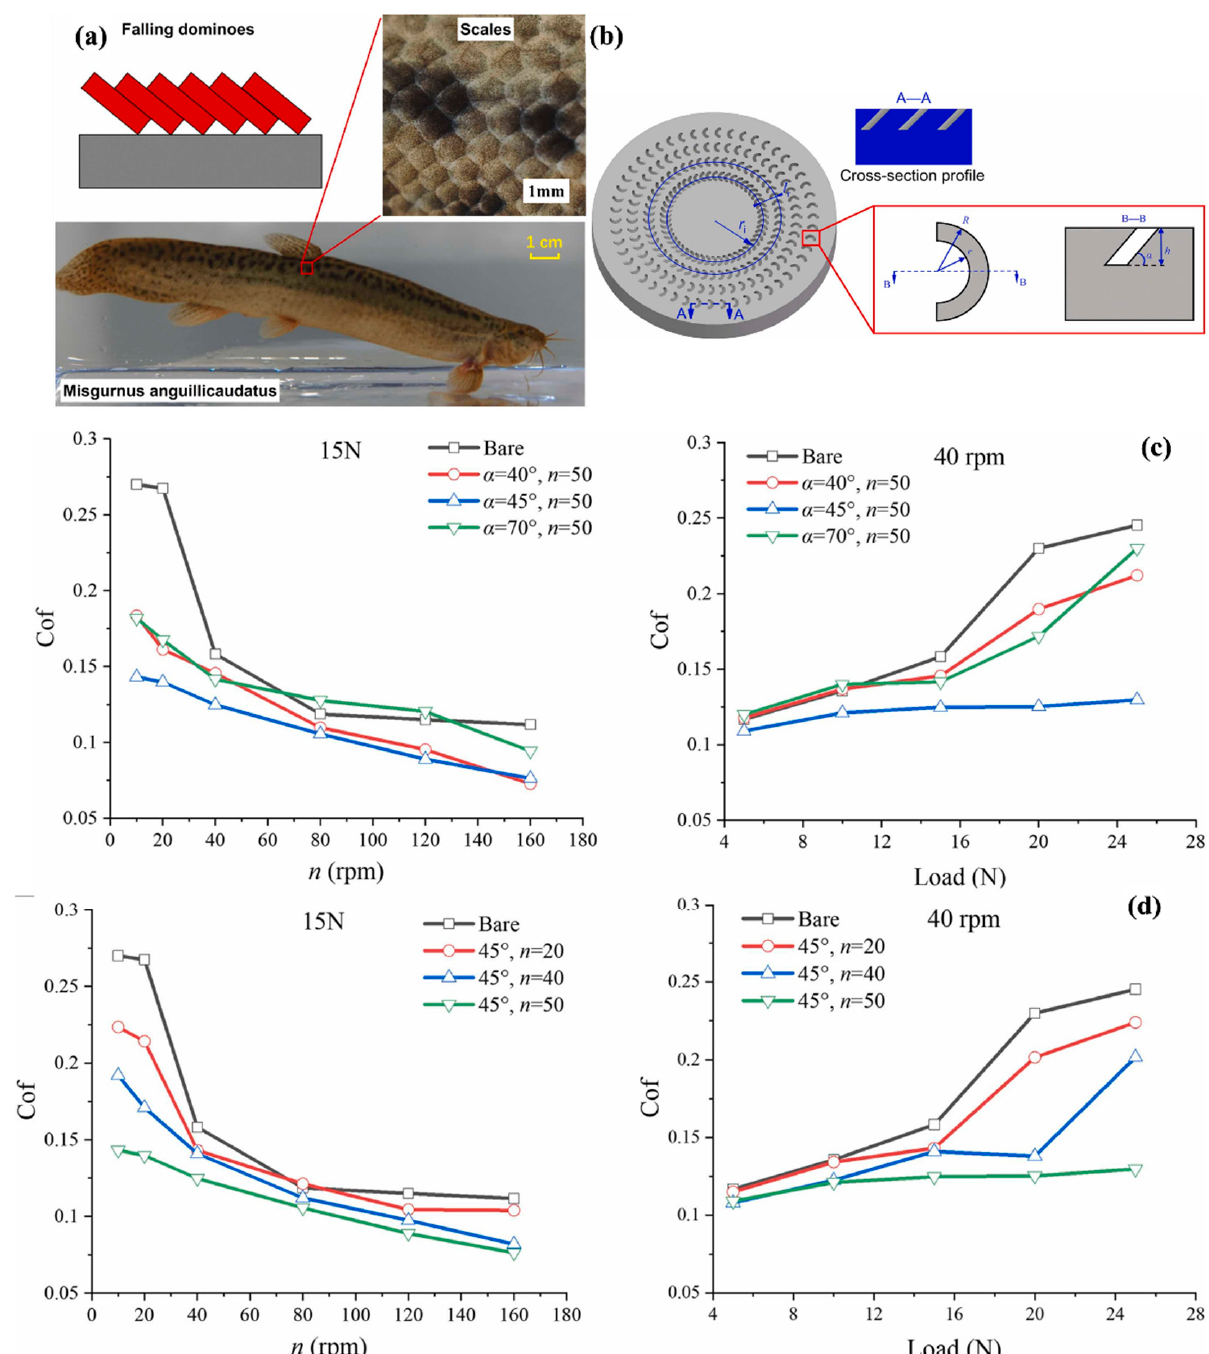
Figure 8. ( a ) loach’s scales are stacked up like falling dominoes, ( b ) geometrical characteristics of a bionic scaly texture and bionic scaly textures placed on a disc, ( c , d ) coefficient of friction was analyzed on the textured surface at different angles and different circumferential directions at a time, compared with the bare specimen [193]. Copyright permission from Elsevier, 2022.